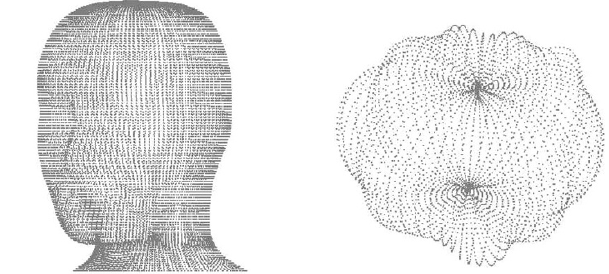
Figure 5: The sampled points of Head and